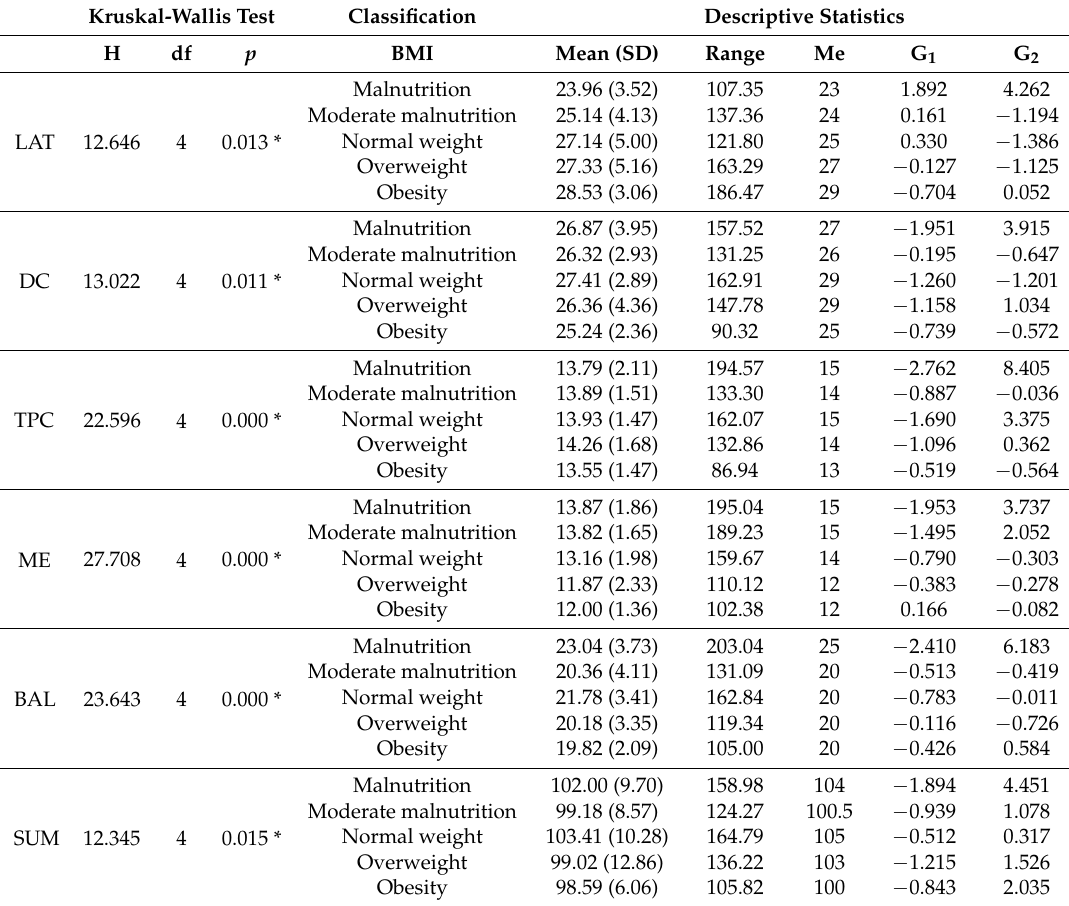
Table 3. Kruskal-Wallis test and descriptive statistics of motor skills according to BMI for the sample of